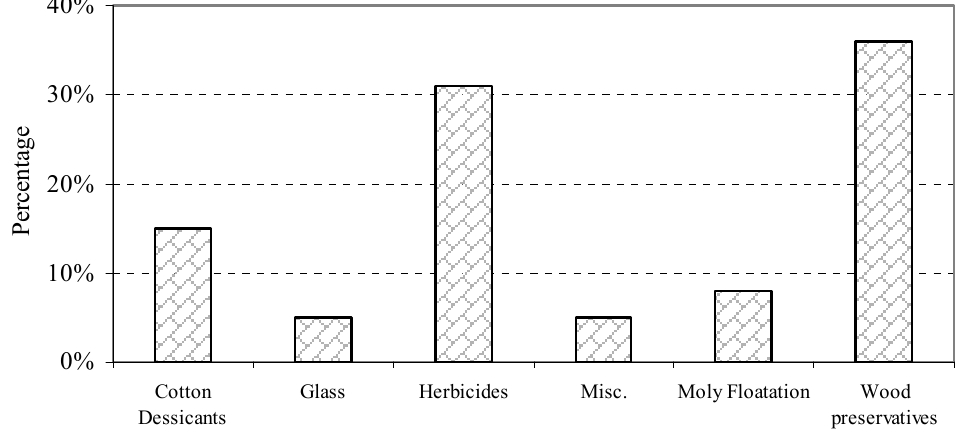
FIGURE 1. Estimated markets for arsenic trioxide in the United States in